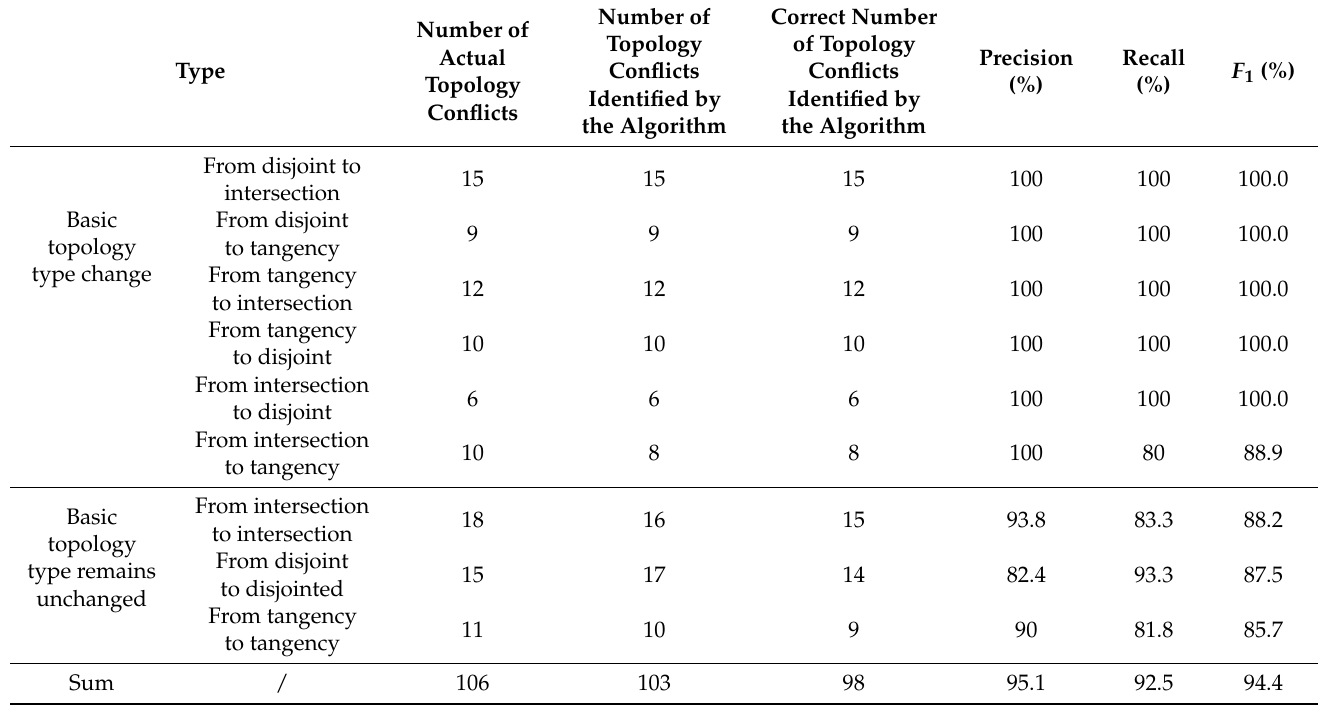
Figure 7. Results of topology conflict detection. Table 3. Statistical results of topology conflict detection.